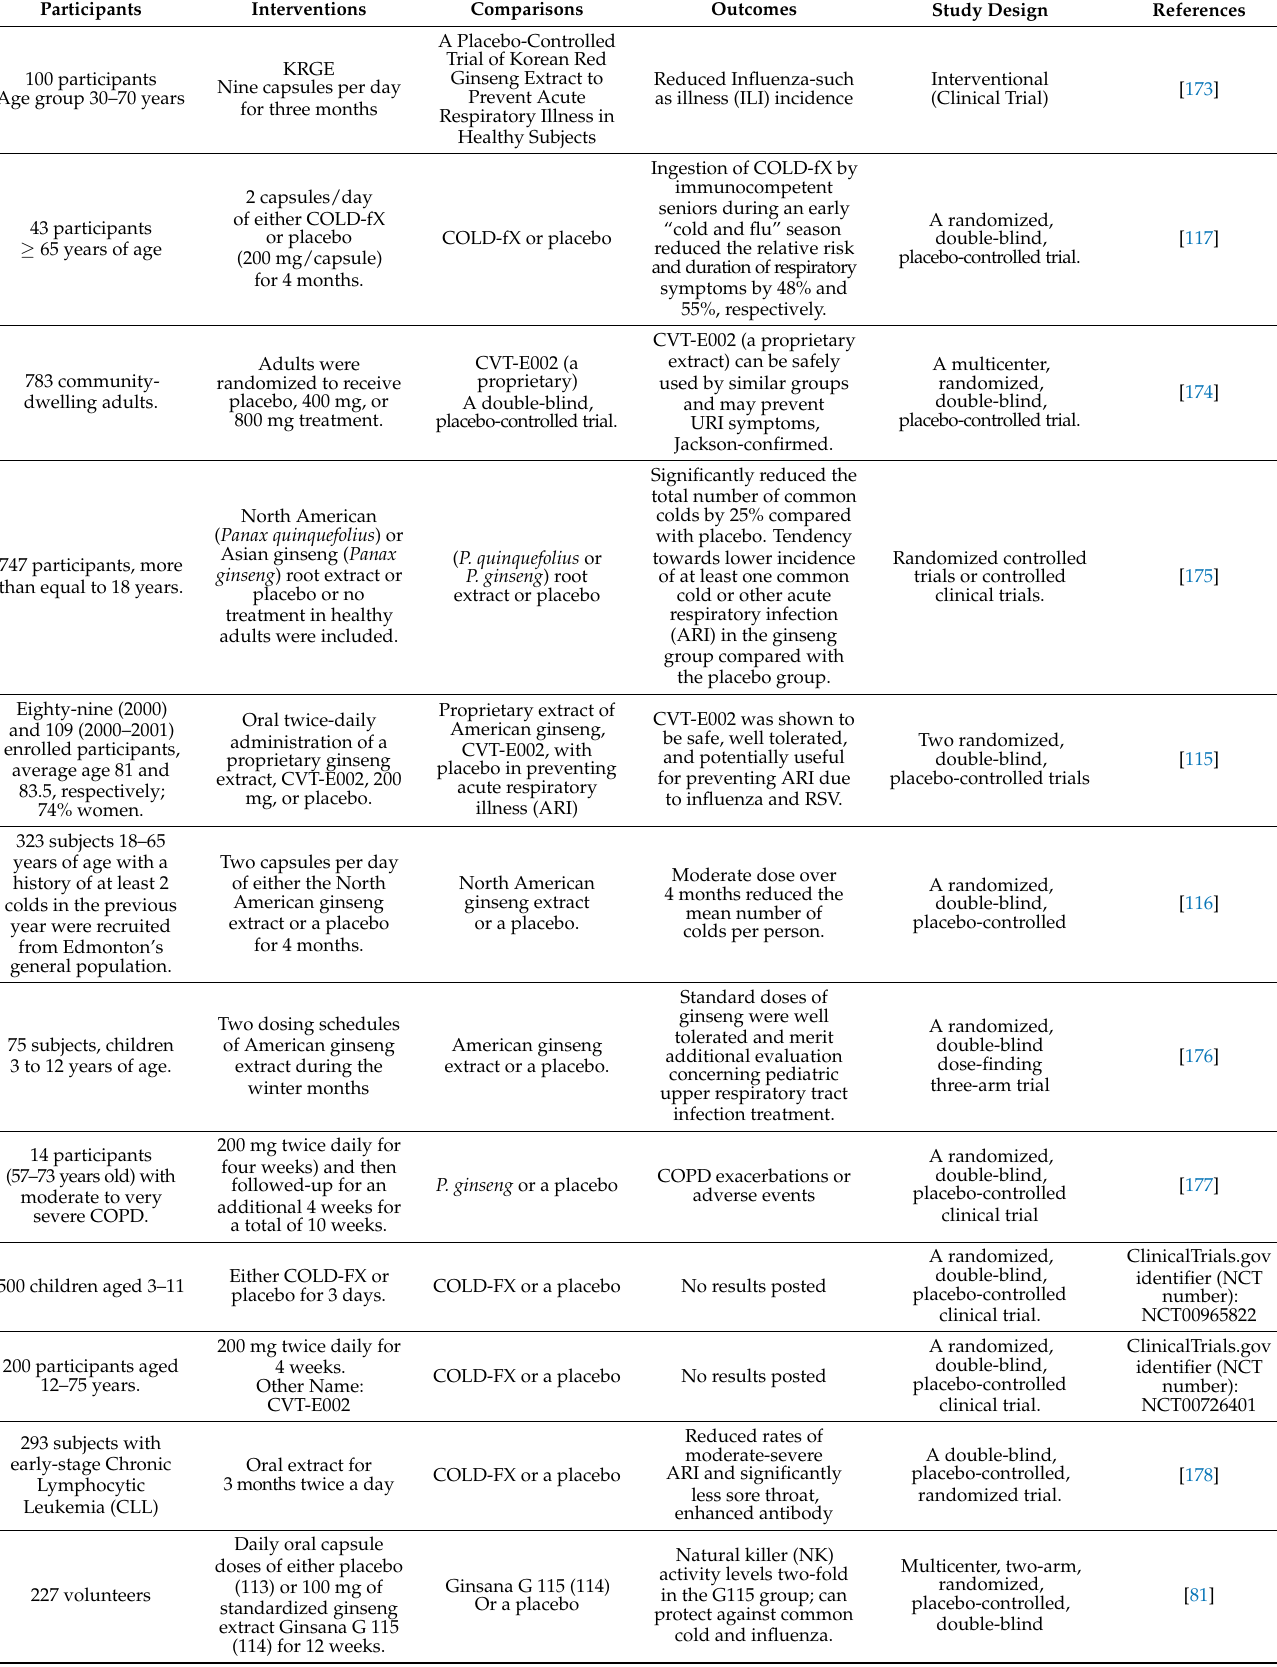
Table 3. Human trial findings to evaluate the effectiveness of ginseng against respiratory